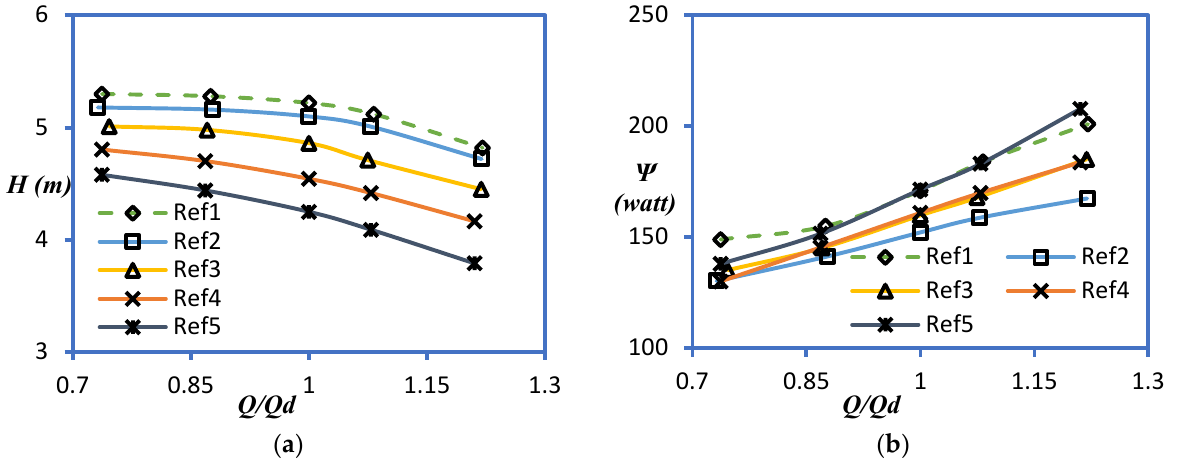
Figure 25. Effect of oil viscosity on pump performance for reference design: ( a ) head rise ( H ) vs. Q/Q d and ( b ) input power ( Ѱ ).